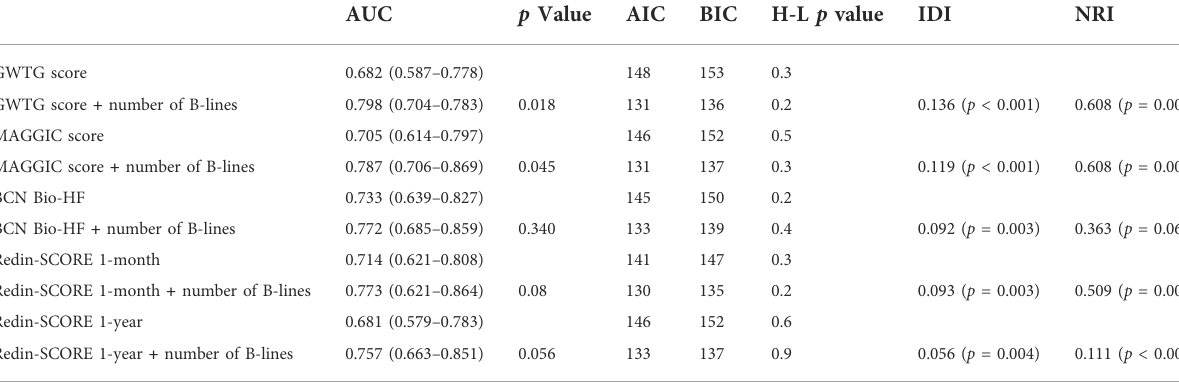
TABLE 2 Incremental prognostic value of B-lines to predict 6-month outcomes in the LUS-HF trial. AUC p Value AIC